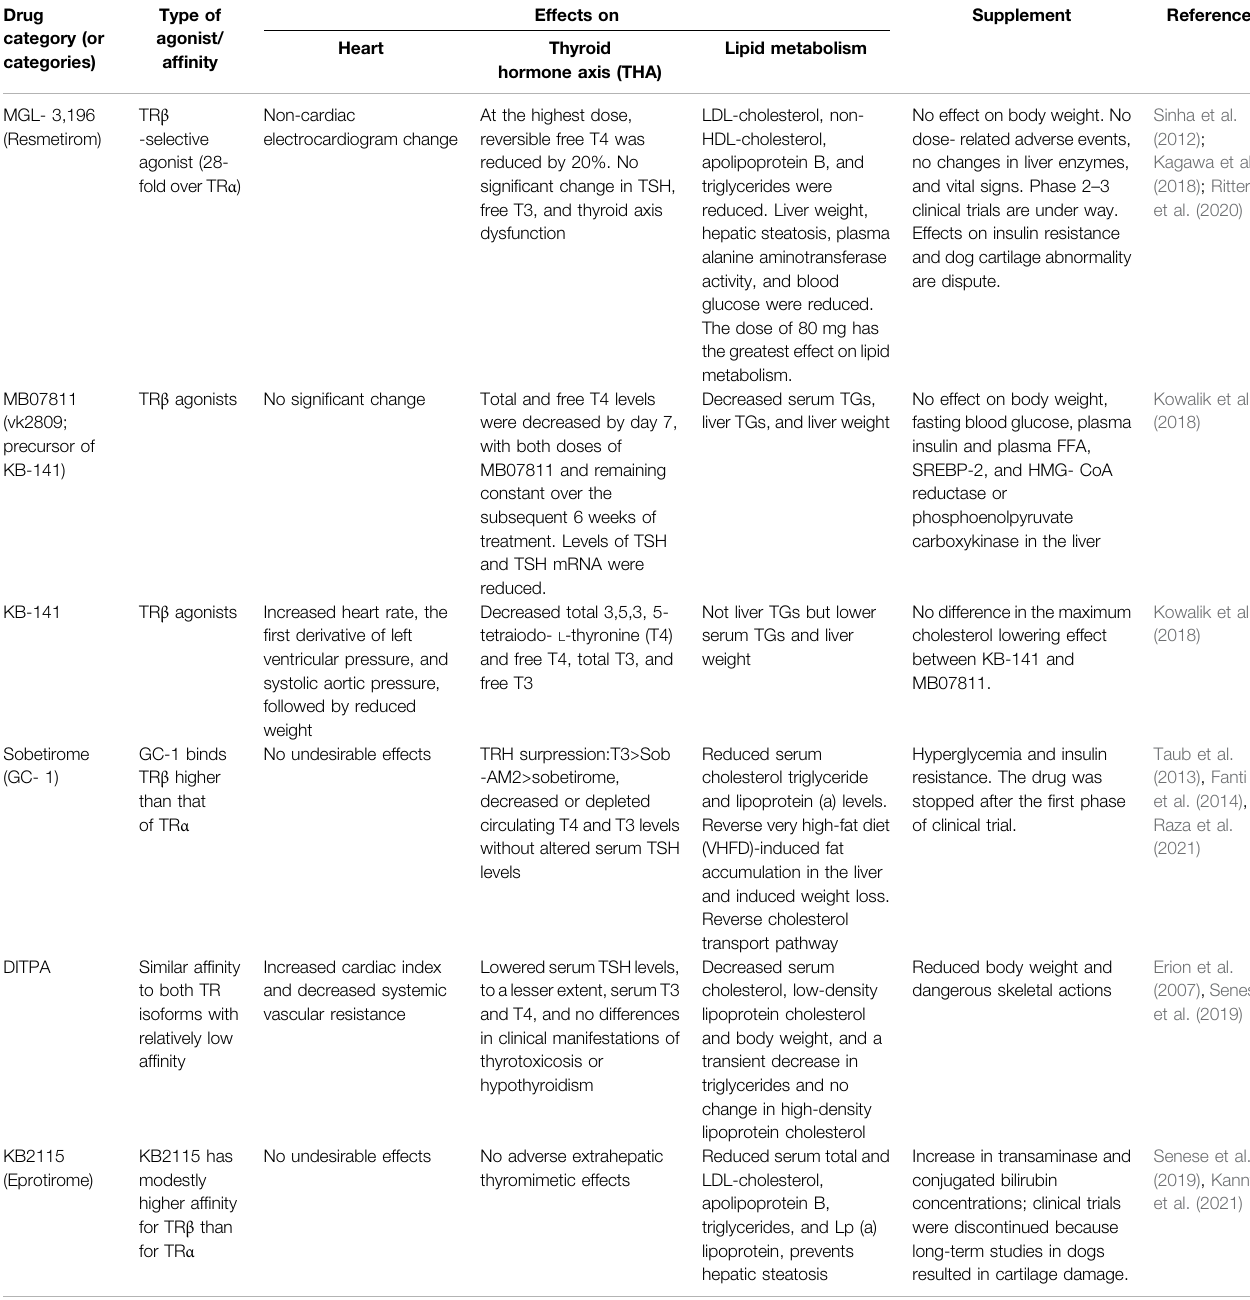
TABLE 1 | Comparison of different effects on selective TR β receptor